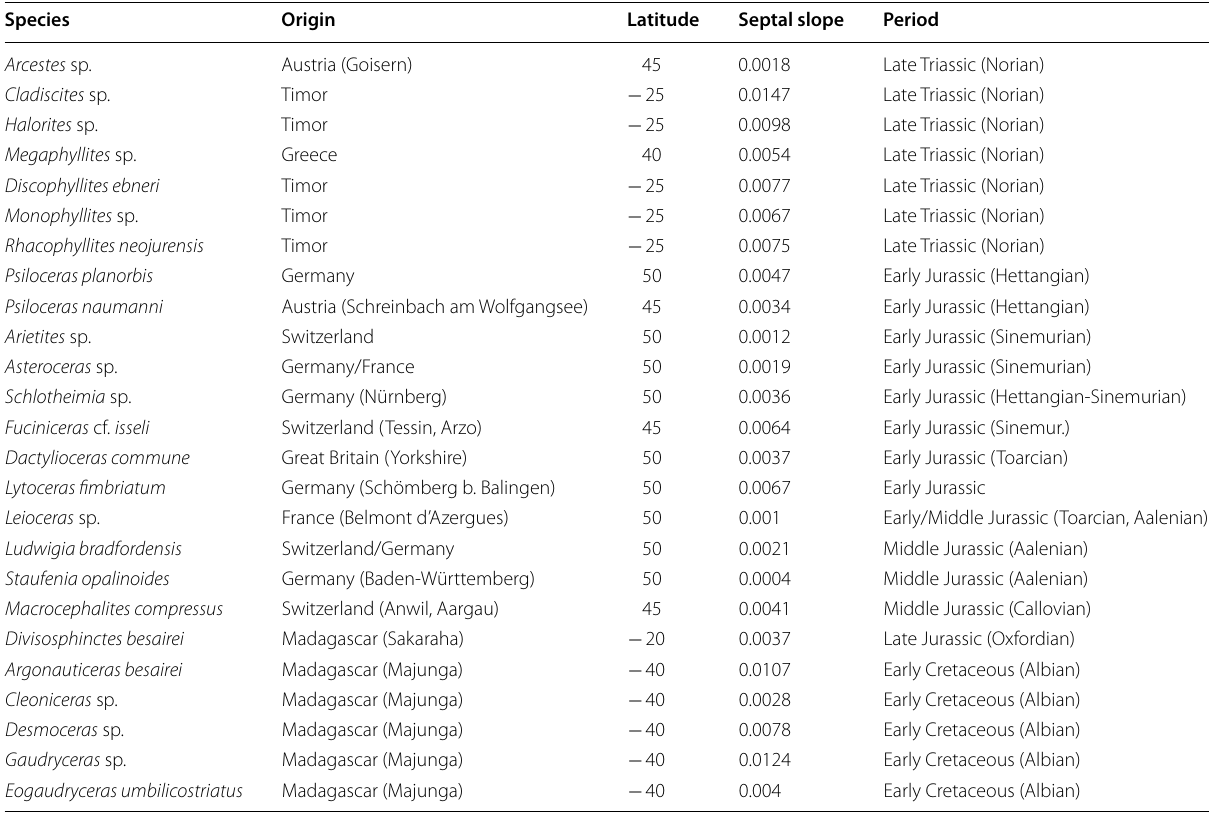
Table 2 Species categorised after geographic origin and period with the corresponding septal slope factor (short: septal slope) and palaeolatitude (after Kocsis & Scotese, 2020) Species Arcestes sp. Cladiscites sp. Halorites sp. Discophyllites ebneri Monophyllites sp.